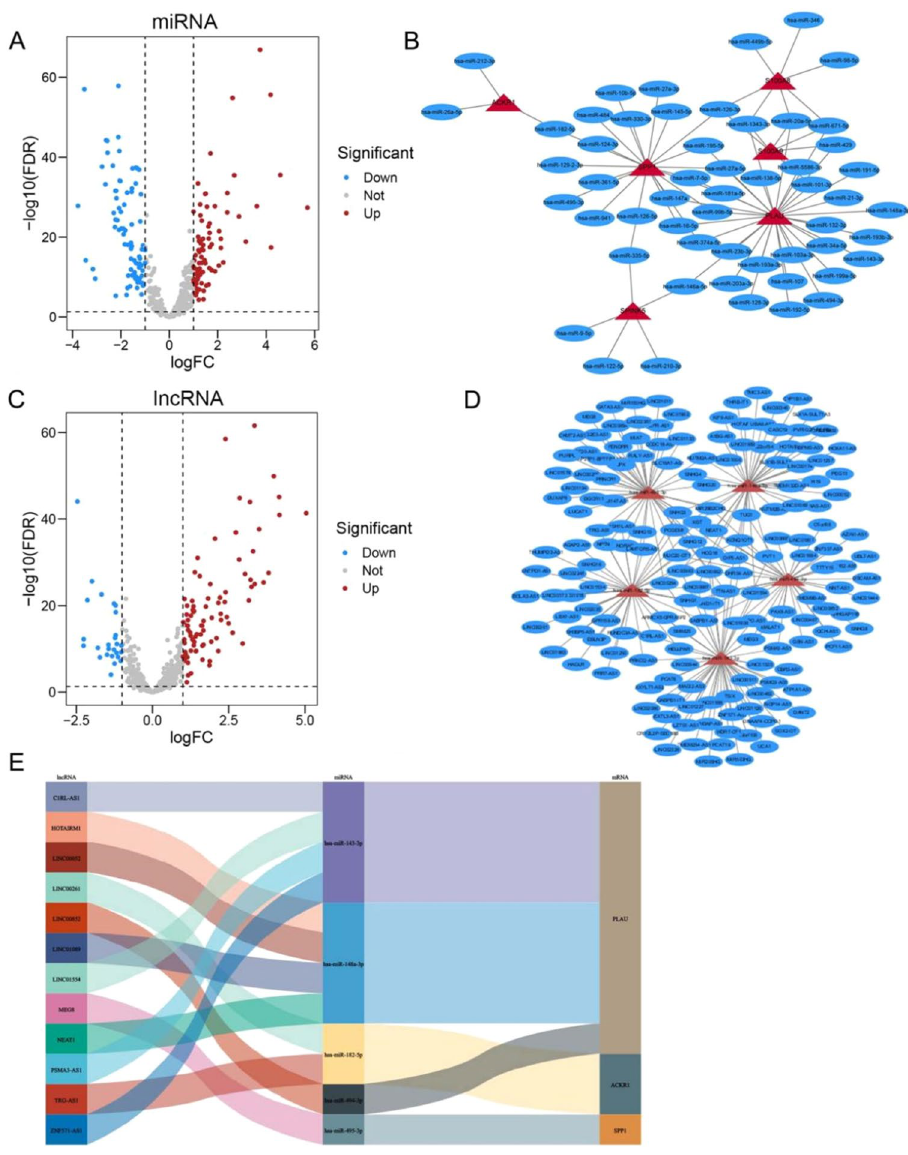
Figure 5. ( A ) The volcano plot of the differentially expressed miRNAs (|log (Fold Change)| > 0.5, adjust p-value < 0.05); blue dots: significantly down-regulated; red dots: significantly up-regulated; grey dots: no significant differences. ( B ) The mRNA-miRNA networks were identified using Tarbase and starBase; blue ellipse: miRNAs; red triangle: mRNAs. ( C ) The volcano plot of the differentially expressed lncRNAs (|log (Fold Change)| > 0.5, adjust p-value < 0.05); blue dots: significantly down-regulated; red dots: significantly up-regulated; grey dots: no significant differences. ( D ) The miRNA-lncRNA networks were identified using miRNet and starBase; blue ellipse: lncRNAs; red triangle: miRNAs. ( E ) Sankey diagram for the ceRNA network in HCC. Sankey diagram showing the potential lncRNA–miRNA–mRNA regulatory